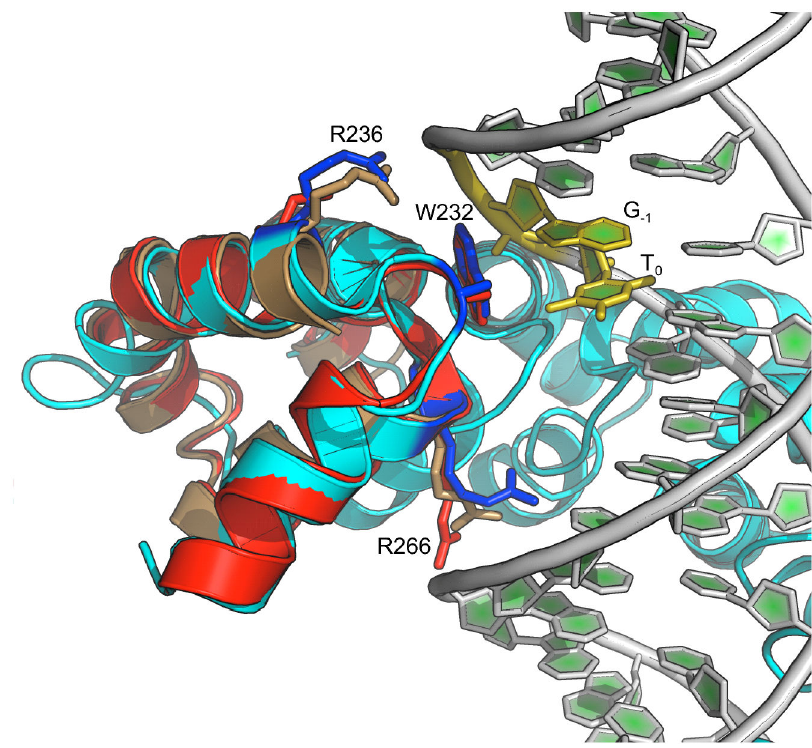
Figure 1. Alignment of N-terminal portions of multiple TAL effector crystal structures shows a conserved conformation for W232 consistent with an important interaction with the 0 th position T. The N terminus of TAL effector PthXo1 bound to its DNA target (PDB structure 3UGM) [4] is shown in blue, the N terminus of unbound artificial TAL effector dTALE2 (PDB structure 4HPZ) [26] in red, and the N terminus of artificial TAL effector dHAX3 bound to a DNA-RNA hybrid (PDB structure 4GG4) [5] in brown. DNA is from structure 3UGM. Side chains are shown for W232 as well as arginines at positions 236 and 266, which make non- specific contacts to the nucleic acid backbone. T , the 0 th position thymine. G , a guanine 5’ of T 0 -1 0